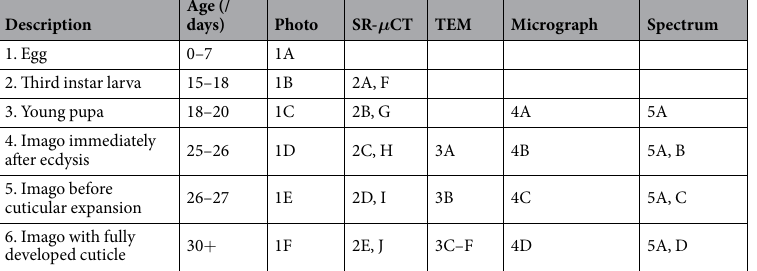
Table 1. Summary of beetle’s life stages considered in this